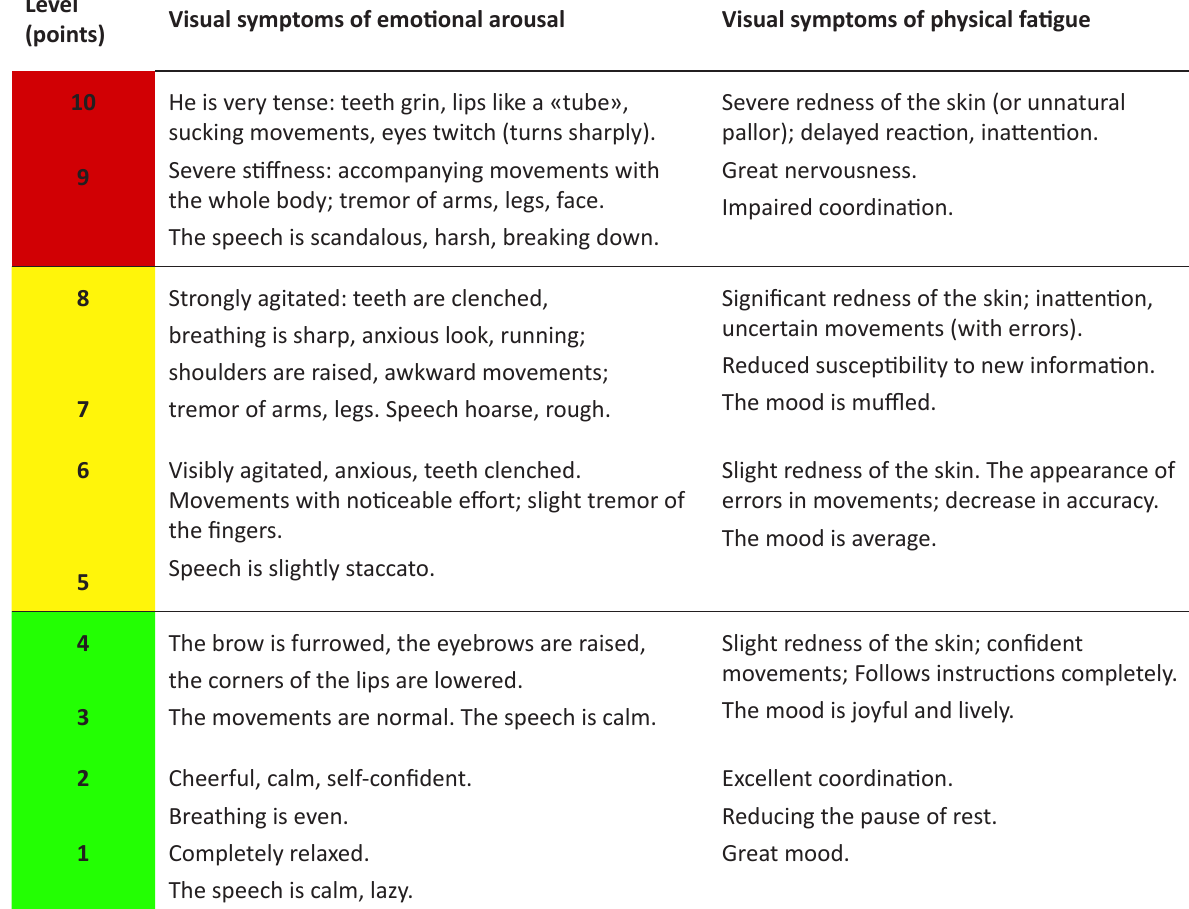
Table 3. Visual control of the level of emotional arousal and the degree of physical fatigue involved